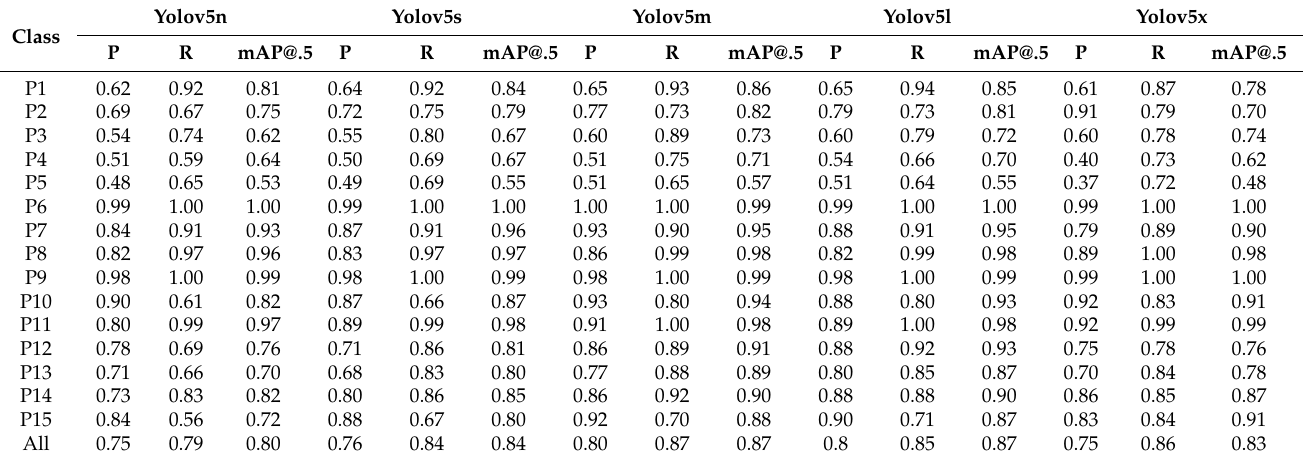
Table 4. Testing Performance of Yolov5